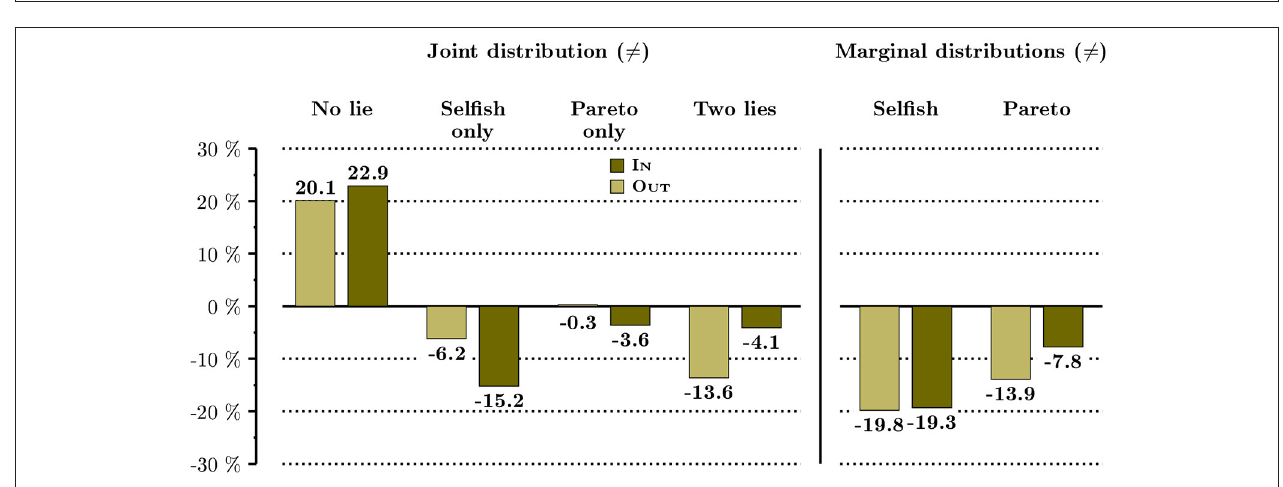
FIGURE 3 | The effect of the oath on the distribution of lying behavior in the sender-receiver game.